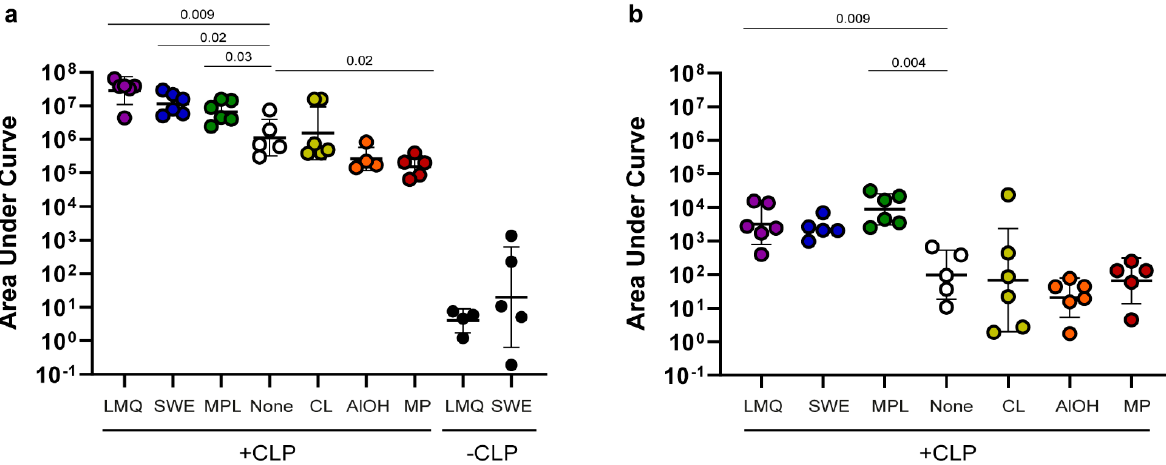
Figure 2. Immunogenicity of antigens on CLP in extrinsic adjuvant formulations: ( a ) SpyCatcher and ( b ) HPV peptide- specific IgG levels measured as the area under the curve (AUC) (AUC = the optical density (O.D.) at 450 nm multiplied by the dilution factor) following immunization with the SpyCatcher-AP205-L2 (+CLP) vaccine formulated in different adjuvants. Specifically, mice were immunized with liposomes/MPL/QS21 (LMQ, purple, n = 6), squalene water emulsion (SWE, blue, n = 6), monophosphoryl lipid A (MPL, green, n = 6), no adjuvants (none, white, n = 5), cationic liposomes (CL, yellow, n = 6), aluminum hydroxide (AlOH, orange, n = 4) or microparticles (MP, red, n = 5). The control groups were immunized with soluble SpyCatcher protein formulated in either LMQ or SWE ( − CLP, black, n = 6 for both groups) using a similar antigen dose (i.e., similar copy number of SpyCatcher) to that used for the SpyCatcher CLP vaccine. Each circle represents the AUC antibody levels obtained in a single mouse in one representative ELISA assay measurement at an O.D. 450 nm cutoff of 0.1. The geometric mean is shown together with the geometric standard deviation. The Kruskal–Wallis test determined that there was a statistic significant difference between two or more groups (( a ) SpyCatcher p < 0.0001 and ( b ) HPV peptide p = 0.0011). For SpyCatcher, Mann–Whitney nonparametric tests were used to compare the LMQ and SWE control vaccines ( − CLP) with their respective LMQ and SWE (+CLP) test vaccines and found significantly increased levels (LMQ p = 0.0095 and SWE p = 0.0043). Hereafter, for both SpyCatcher and the HPV peptide, uncorrected, pairwise Mann–Whitney tests were used to compare the different +CLP adjuvant groups with the un-adjuvanted CLP. Only significant p -values in